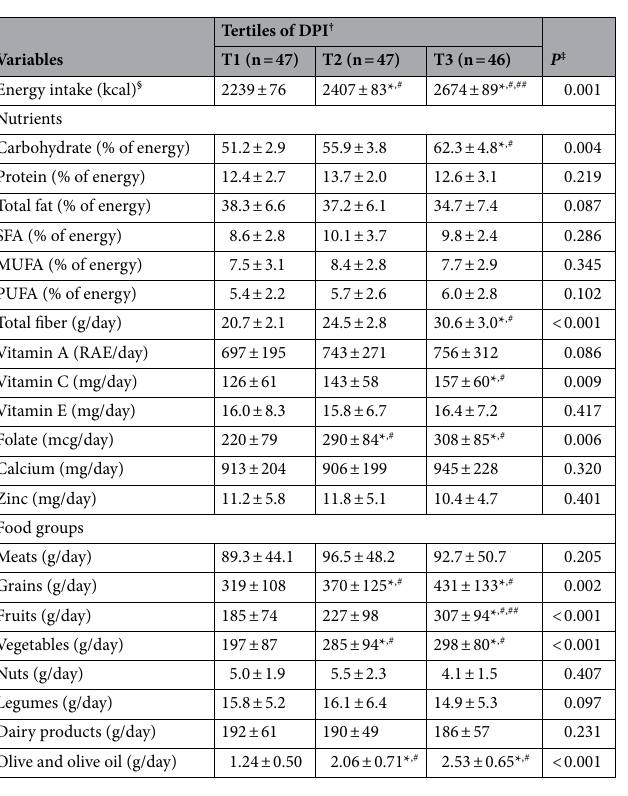
Table 2. Dietary intakes of subjects with obesity across tertiles of DPI. Data are expressed as mean ± standard deviation. DPI dietary phytochemical index, RAE retinol activity equivalents. † Tertile cut-points of DPI are as follows: first tertile, < 27.3; second tertile, 27.3 to 33.9; third tertile, > 33.9. ‡ Obtained from analysis of covariance (ANCOVA). § Energy intake is adjusted for sex and age; all other values are adjusted for age, sex and energy intake. * P < 0.05 (Obtained from Tukey post hoc test). # Significant difference from first tertile. ## Significant difference from second